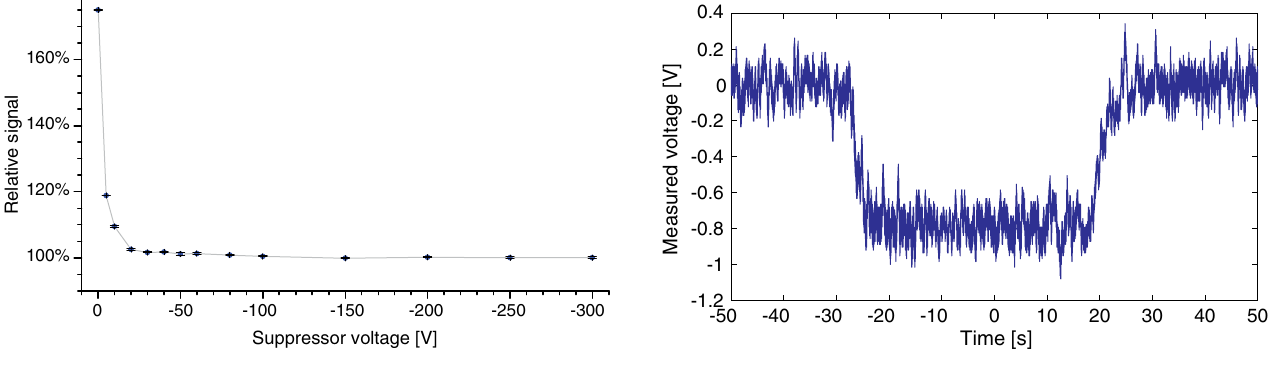
FIG. 19. Response of the Faraday cup to a chopped beam corresponding to about 80 fA registered at 10 13 V = A .